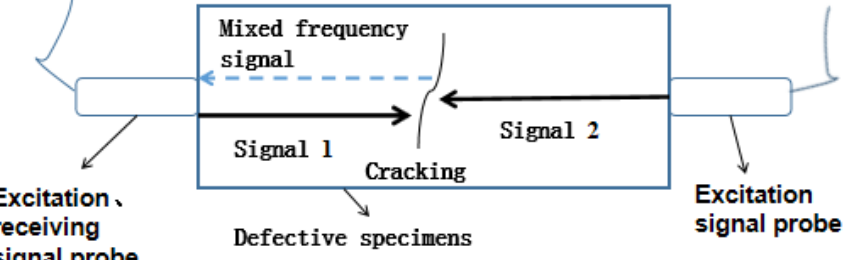
Figure 1. The principle about hetero-side collinear mixing ultrasonic detection.